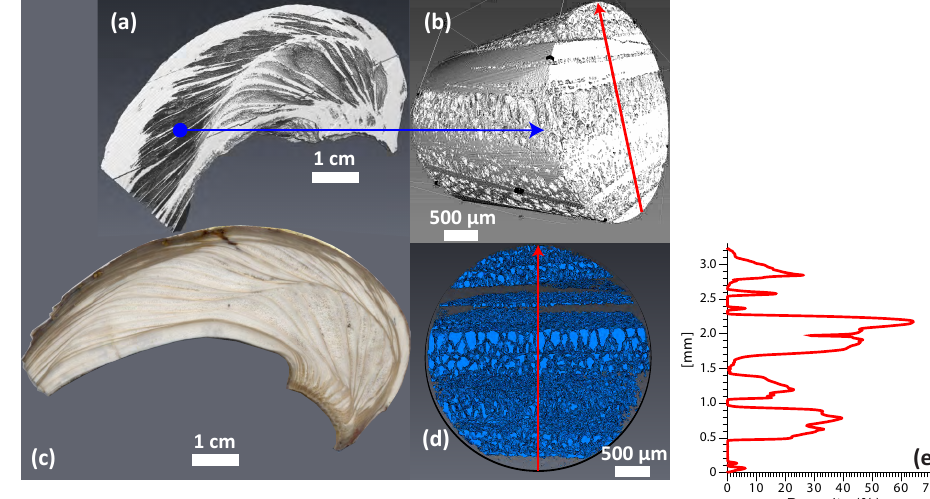
Figure 4. Overview of the results of CT scanning and porosity analysis on specimen M4, with (a) showing an overview of density variations in the shell (white shows dense calcite, darker colours represent porosity). The blue dot shows the location of the part of the shell that was CT scanned at high resolution. (b) shows the shape and density of a part of the shell that was CT scanned with higher spatial resolution as well as the location of the porograph shown in (e) . (c) shows a colour scan of the shell cross section. (d) shows a high-resolution cross-section through the shell with porosity in blue (light blue shows porosity, darker colours show dense calcite). The red line is in the same location as in (b) . (e) shows a graph of porosity through the high-resolution section perpendicular to the growth